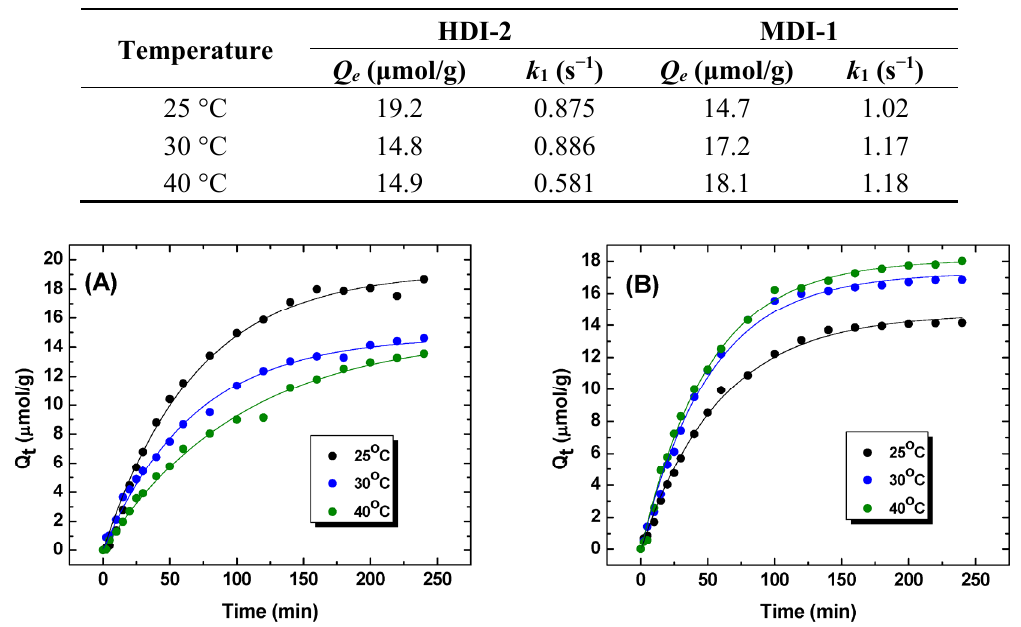
Figure 3. Kinetic uptake profiles for PUs with phth at pH 10.5 and variable temperatures (25, 30 and 40 °C) using Method C for; ( A ) HDI-2 and ( B ) MDI-1. The solid lines represent “best-fit” using a pseudo-first order (PFO) kinetic